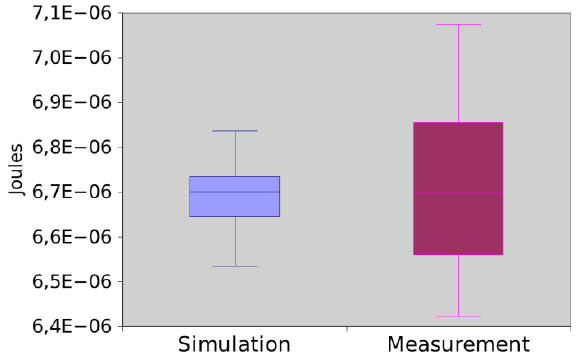
Figure 13. Power consumption of App1 .